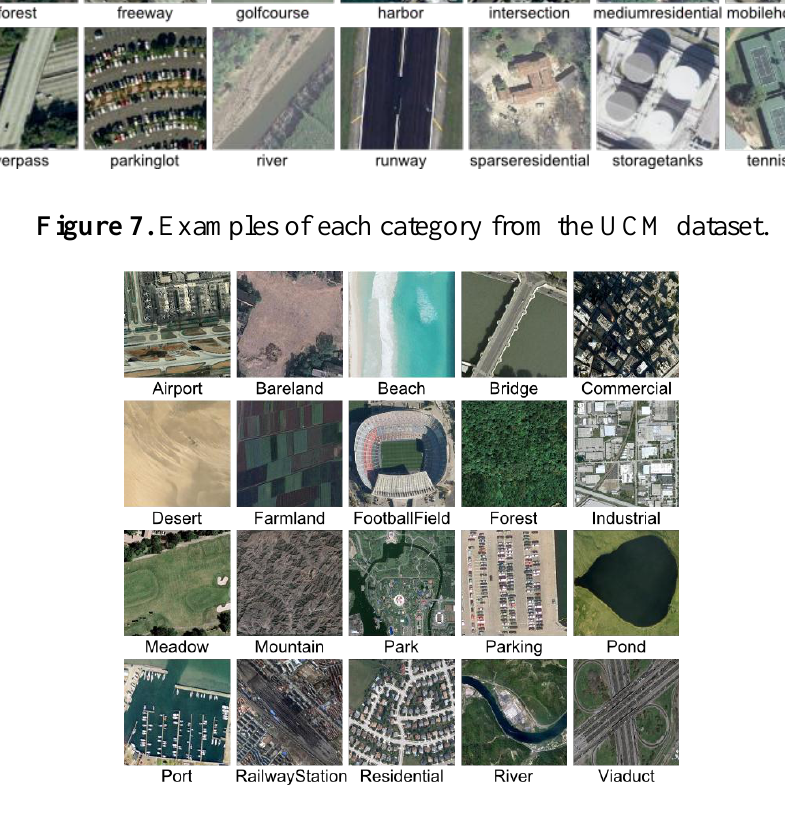
Figure 8. Examples of each category from the WHU-RS dataset [55].